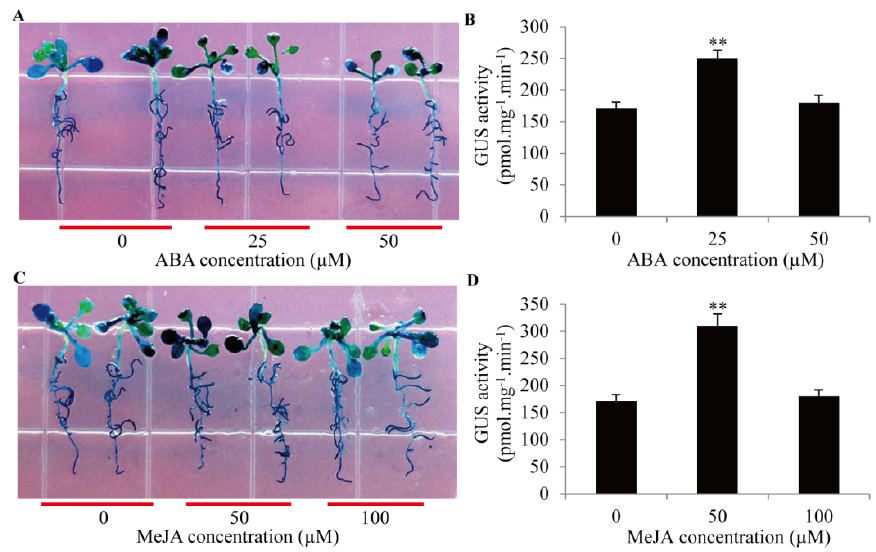
Figure 6. GUS activities of the GmTIP1;6 promoter under ABA and MeJA hormone treatments in transgenic Arabidopsis . ( A , C ) GUS staining for proGmTIP1;6-GUS transgenic seedlings treated with different hormone signals (25–50 µM ABA or 50–100 µM MeJA). ( B , D ) Activity analyses of GUS protein in transgenic seedlings under different hormone treatments. ** indicated significant differences in comparison with the control treatment, p < 0.01 ( t -test).